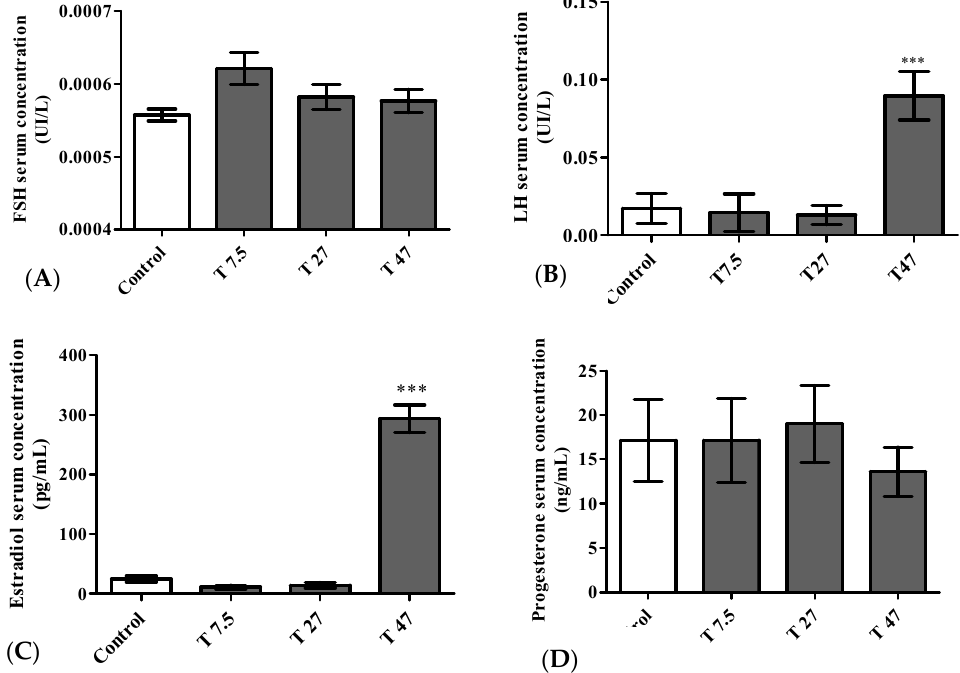
Figure 8. Serum concentration of Follicle Stimulating Hormone (FSH) ( A ), Luteinizing Hormone (LH) ( B ), Estradiol ( C ) and Progesterone ( D ) of immature female Wistar rats after 40 days of treatment. Control = animals receiving vehicle (distilled water, 10 mL/kg BW); T = rats treated with tartrazine at doses of 7.5; 27, and 47 mg/kg BW. Results are shown as a mean ± SEM; n = 5. ***: p < 0.001 in reference to